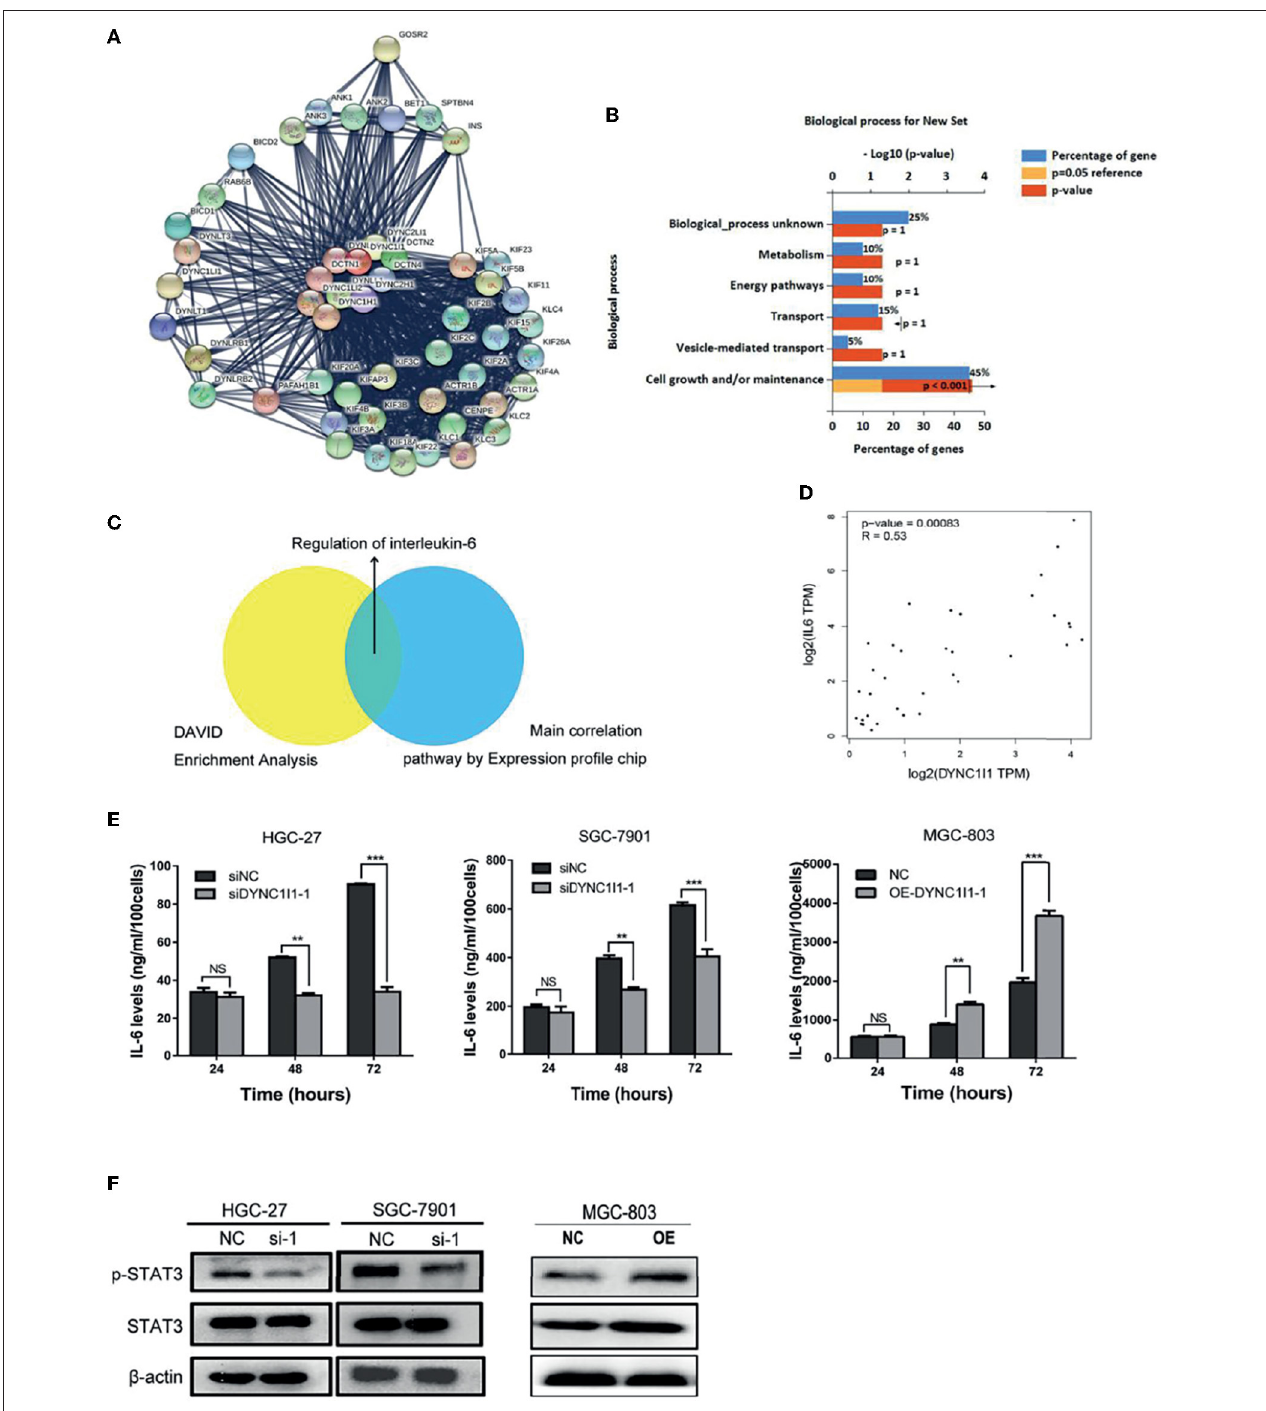
FIGURE 5 | DYNC1I1 may function by regulating the IL-6 pathway. (A) Sting Website enrichment DYNC1I1 related genes and FunRich software enrichment related pathway. (B) FunRich software for Biological Pathway Enrichment Analysis. (C) Expression profile chip shows the main correlation pathway about DYNC1I1. (D) GEPIA website analysis the correlation between DYNC1I1 and IL-6 in gastric cancer. (E) Elisa shows the change of IL-6 expression after knocking down or overexpression DYNC1I1. (F) Western blot indicates the differential levels of STAT3, P-STAT3. β -actin was used as a loading control in Western blot. (** P < 0.01, *** P < 0.001, n = 3, student t -test, means ± 95% CI).